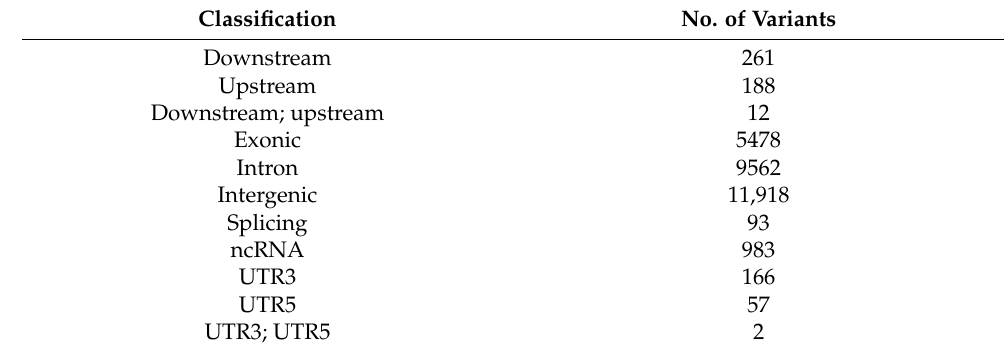
Table 2. Annotation of the merged CNVs.